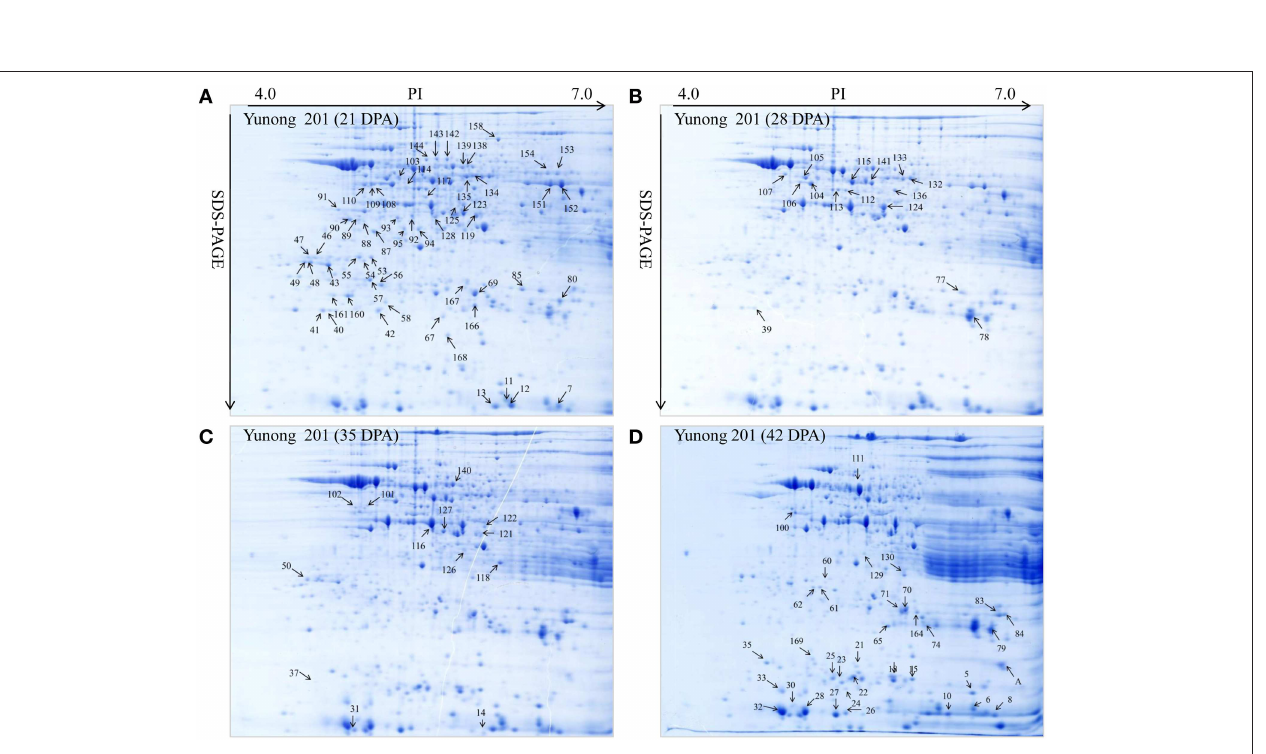
Frontiers in Plant Science |